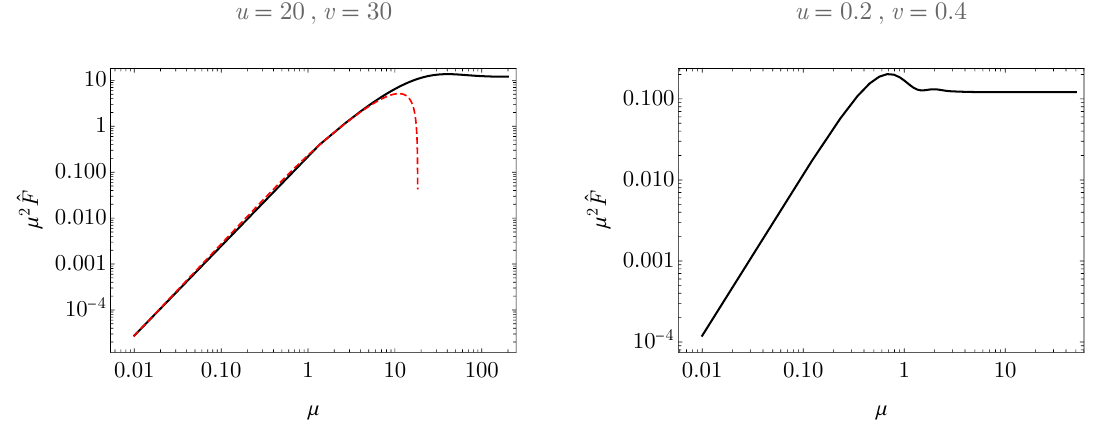
ˆ Figure 8 . The four-point function F ( u, v ) multiplied by mass squared as a function of µ , for fixed values of u and v . Left : The dashed line indicates F (4.40). The 1 /µ 2 behaviour of asympt ˆ F ( u (cid:29) 1 , v (cid:29) 1) is not reached before µ grows larger than max ( u, v ) . Right : In contrast to the previous case, when u and v are both within the unit disk, ˆ F starts to decay as 1 /µ 2 for µ & 1 . In both diagrams we have normalized to g = 1